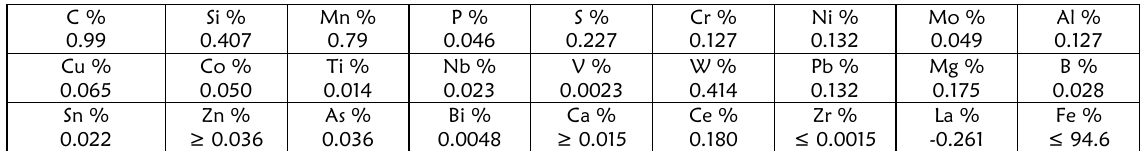
Table 3: Chemical composition of high carbon alloy steel